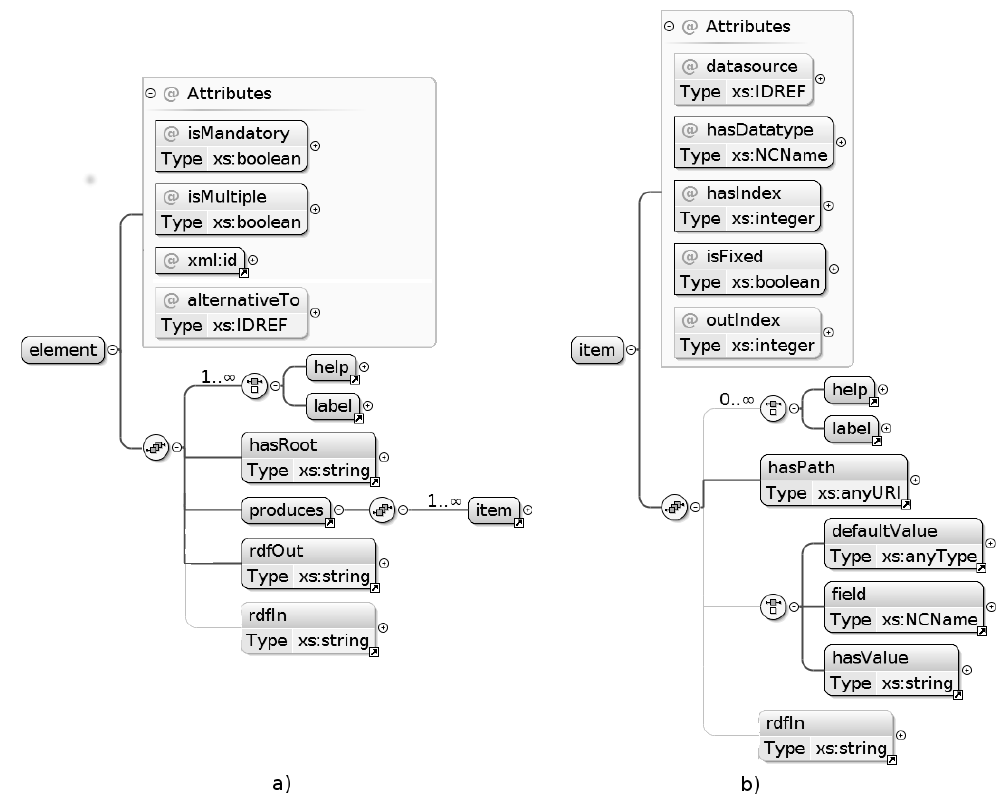
Figure 3. The element ( a ) and item ( b ) XML Schema